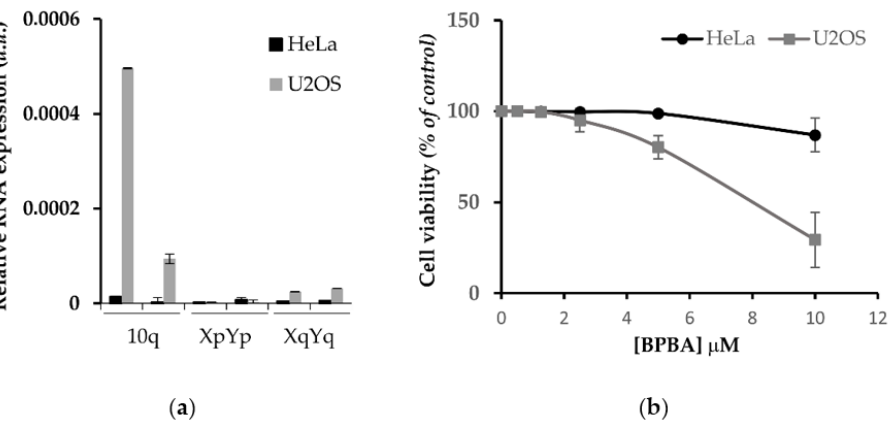
Figure 7. Differential effect of BPBA on viability of high vs. low TERRA expressing cells. ( a ) RT qPCR showing relative expression of specific TERRA RNA at different subtelomeric loci (10q, XpYp, XqYq) of HeLa, and U2OS cells; ( b ) HeLa and U2OS exposed to indicated doses of BPBA and, after 6 days, analyzed by crystal violet assay to determine the fraction of surviving cells. Percentages of surviving cells relative to untreated samples and mean of three independent experiments are shown. Error bars are SD.